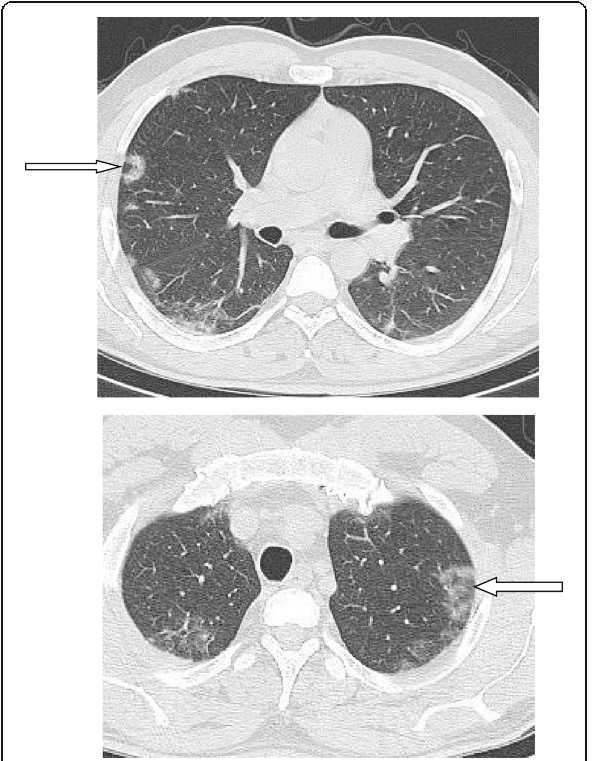
Fig. 17 Patient with COVID-19 pneumonia with reversed halo sign